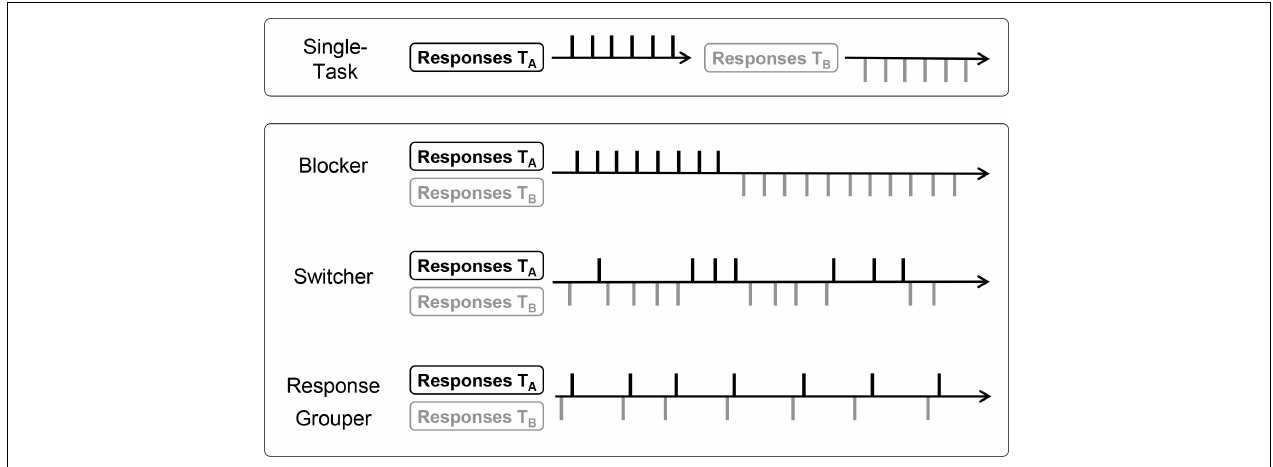
FIGURE 1 | Illustration of characteristic response patterns of each strategy of response organization. Figure taken from Brüning et al. (2020, p. 3). Letters T A and T B refer to Task A and Task B, respectively.